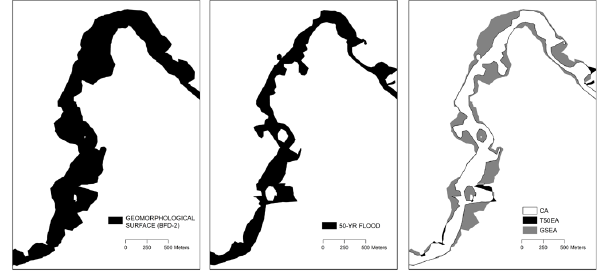
Fig. 5. Delineation of coinciding area (CA), 50-yr flood exceed- ing area (T50EA) and geomorphological surface exceeding area (GSEA) to evaluate the adjustment between geomorphological (BFD-2) and hydrological criteria (50-yr flood) derived surfaces.